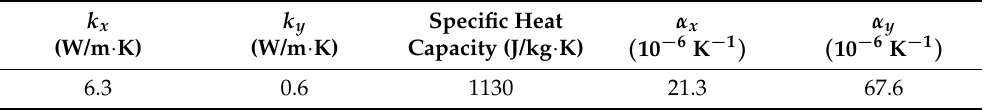
Table 2. CFRP’s thermal